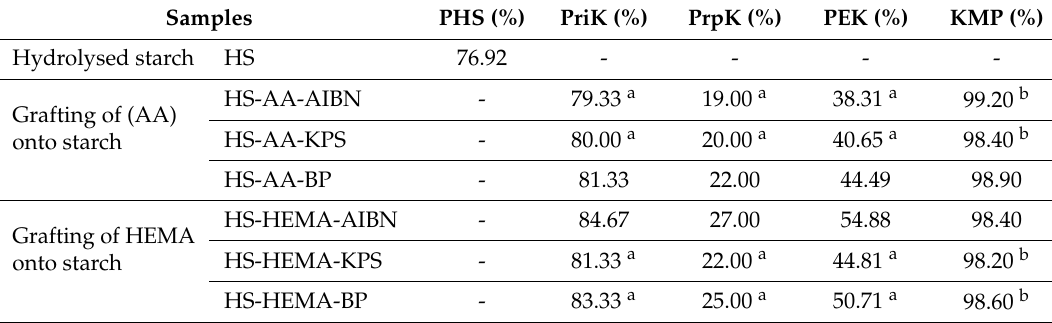
Table 2. Obtained yield values.